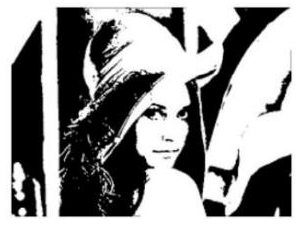
Figure 3. Binarized image.